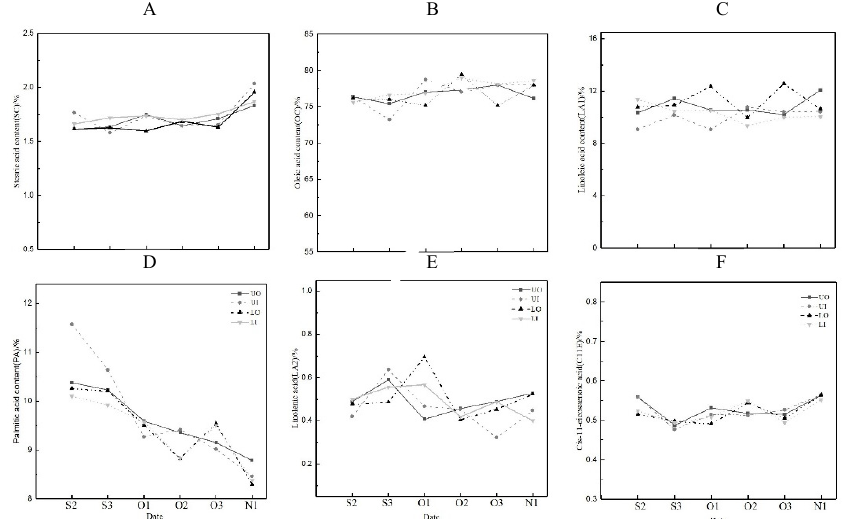
Figure 6. ( A ) Stearic acid, ( B ) oleic acid, ( C ) linoleic acid, ( D ) palmitic acid, ( E ) linolenic acid, ( F ) cis-11-dodecenoic acid content in C. oleifera ‘Huaxin’ from September 2021 to November 2021.